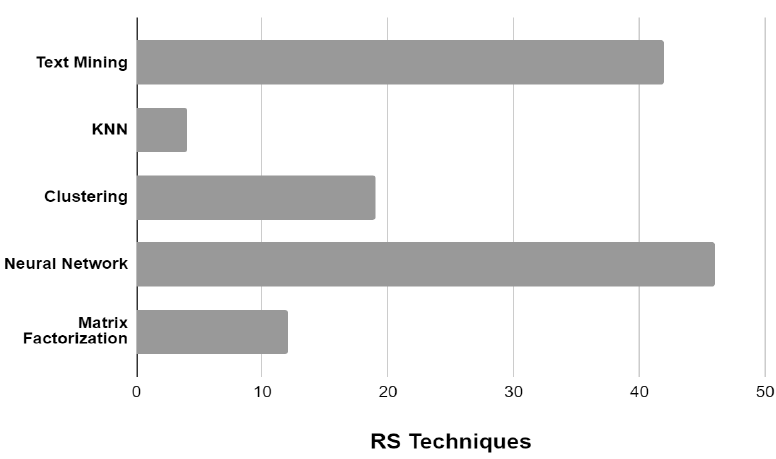
Figure 14. Frequency (number) of papers using recommendation techniques during the period investigated in this paper (2010–2020).